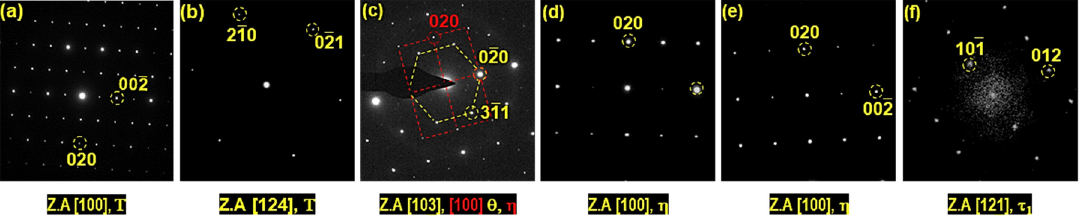
Figure 7. Diffraction patterns obtained from areas denoted by 1–6 in Figure 6. (T: Al 9 FeNi; θ : FeAl 3 ; τ 1 : Al 2 Fe 3 Si 3 ; η : Fe 2 Al 5. ) Table 3. EDS results and suggested phases in the area denoted as 1–7 in Figure 6a.